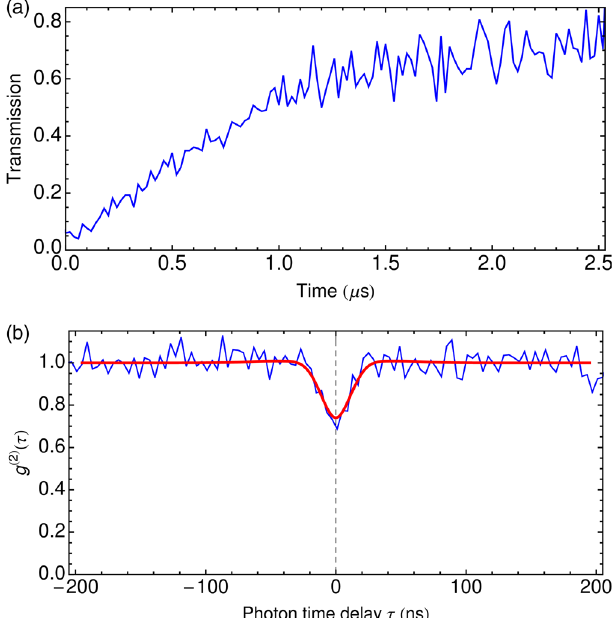
FIG. 5. Control of the nonreciprocal transmission using a single resonator-enhanced atom. (a) Measured transmission T − as function of time. Because of optical pumping into the Zeeman − 3 i , the system changes its trans- ground state j F ¼ 3 ; m F ¼ mission properties and, after about 2 μ s, the directionality of the optical diode reverses. (b) Second-order correlation function g ð 2 Þ of the light transmitted through the nanofiber in the ( þ z ) direction. The thin blue (thick red) line corresponds to the measured data (theoretical prediction). For zero time delay one observes photon